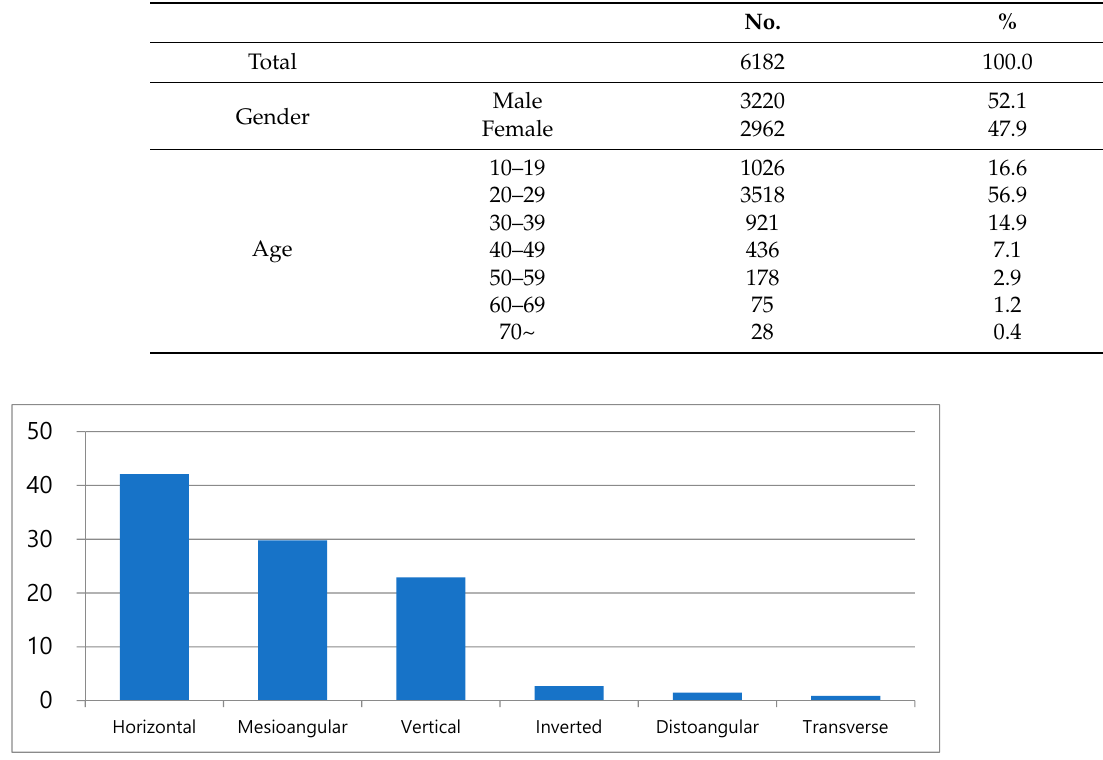
Figure 6. Distribution of the Winter classification: horizontal impaction (42.1%), mesioangular impaction (29.8%), vertical impaction (22.9%), inverted impaction (2.7%), distoangular impaction (1.5%), and transverse impaction (0.9%).